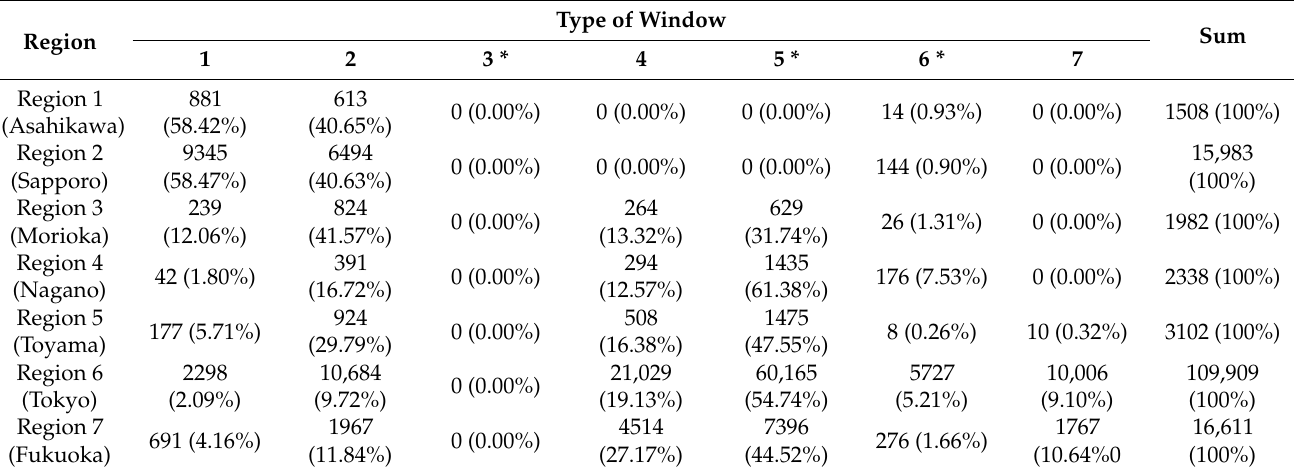
Table 4. Application frequency or window assembly according to